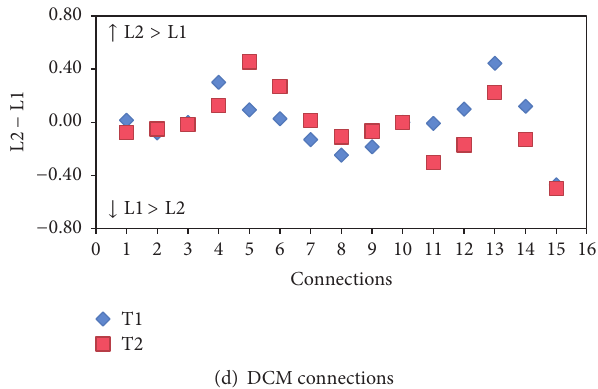
Figure 3: Patient 1. (a) Ischemic stroke in left frontotemporal area in the T1-weighted MRI image at T1. (b) Pattern of brain activation in different conditions while picture naming, with an uncorrected 𝑝 < 0.001 for the main effects. (c) Behavioral results of the combined production scores in both languages, linguistic and nonlinguistic switching scores across sessions. ∗ represents 𝑝 value < 0.05. (d) Differences between L1 strength values and L2 strength values for each single connection across sessions. (1) ACC to LIFGTri. (2) ACC to LIFGOrb. (3) ACC to LC. (4) LC to ACC. (5) LC to LIFGTri. (6) LC to LIFGOrb. (7) LIFGTri to LC. (8) LIFGTri to ACC. (9) LIFGOrb to LC. (10) LIFGOrb to ACC. (11) LIFGTri to LIFGOrb. (12) LIFGOrb to LIFGTri. (13) BTLA to LIFGTri. (14) BTLA to LIFGOrb. (15) BTLA to